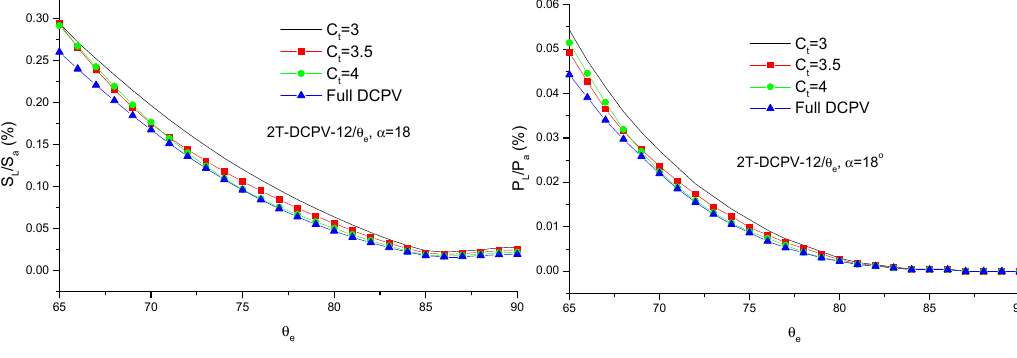
Figure 17. As in Figure 16 but for 2T-DCPV-12/ θ e Figure 17 . As in Figure 16 but for 2T-DCPV-12/ e Figure 17 . As in Figure 16 but for 2T-DCPV-12/ e